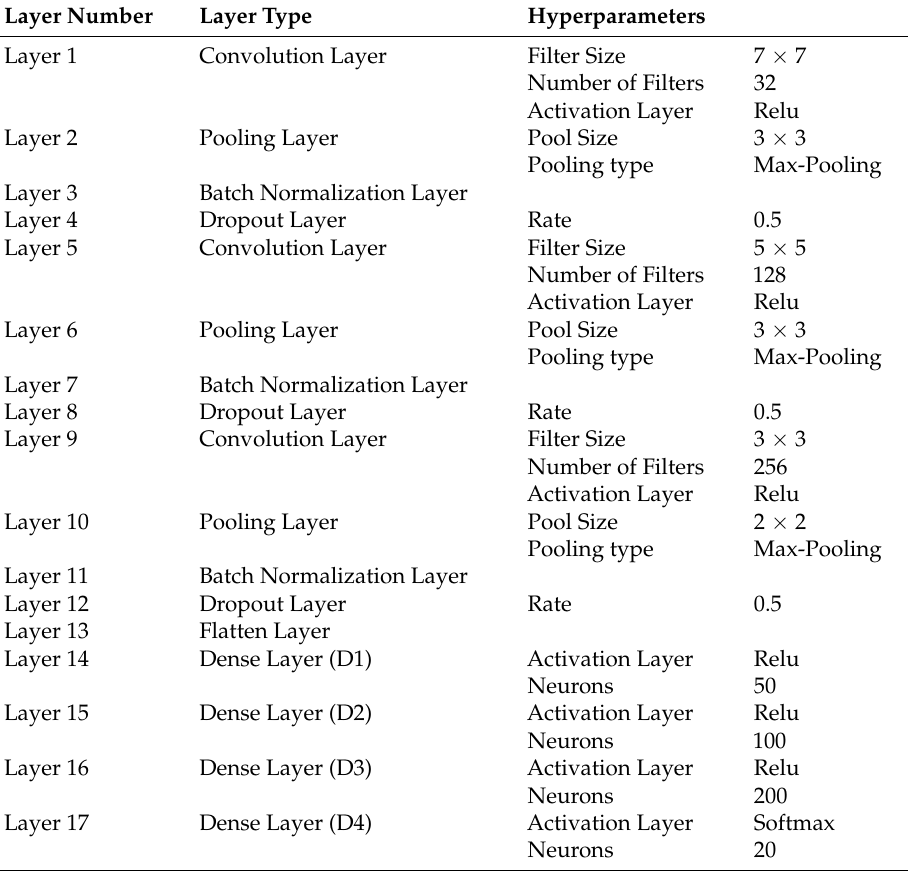
Table 3. Detailed Configuration of CNN